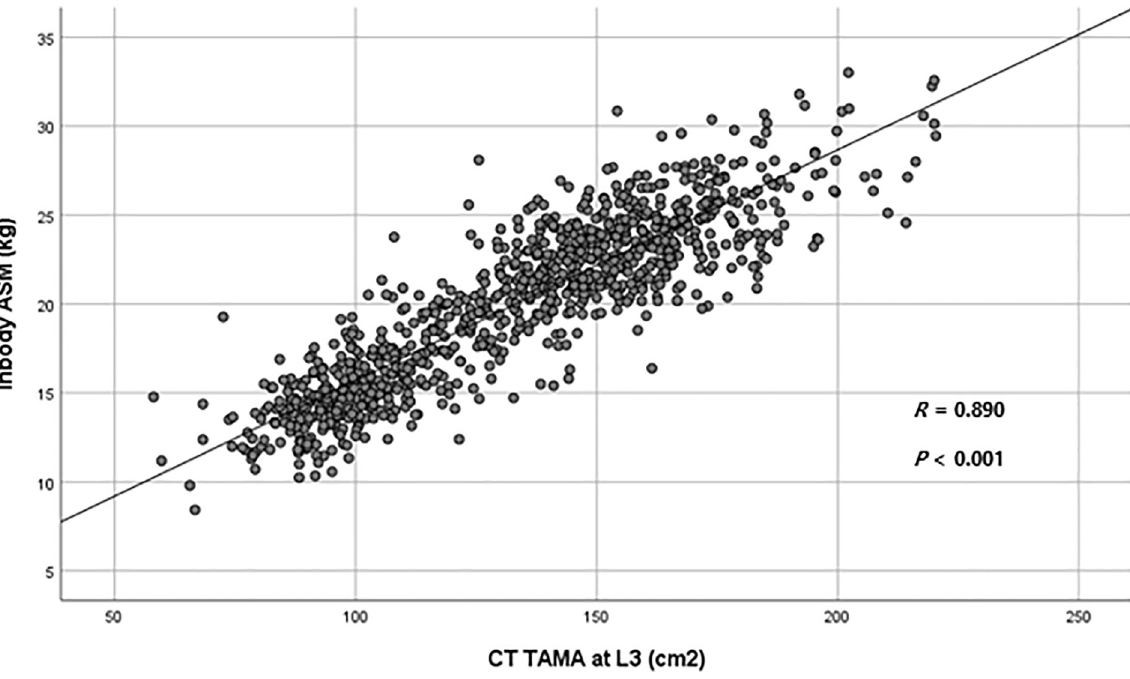
Fig 5. Correlation between the appendicular skeletal muscle mass (ASM) measured by Inbody 720 and the total abdominal muscle area measured by computed tomography (CT) scan. ASM, Appendicular skeletal muscle mass; TAMA, Total abdominal muscle area; CT, Computed